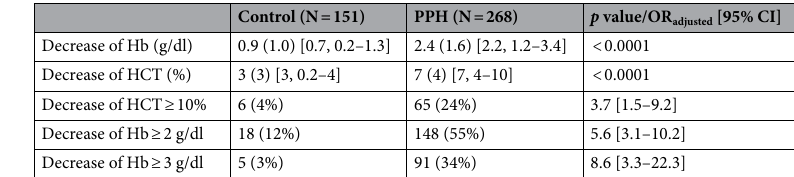
Table 2. Decrease in hemoglobin and hematocrit during the immediate postpartum period. Values are presented as mean (SD) [median, interquartile range] or number (percent). OR was adjusted for primiparity, epidural, perineal tears, episiotomy, Hb before delivery, HCT before delivery, delivery number and delivery week. Hb hemoglobin, HCT hematocrit, OR odds